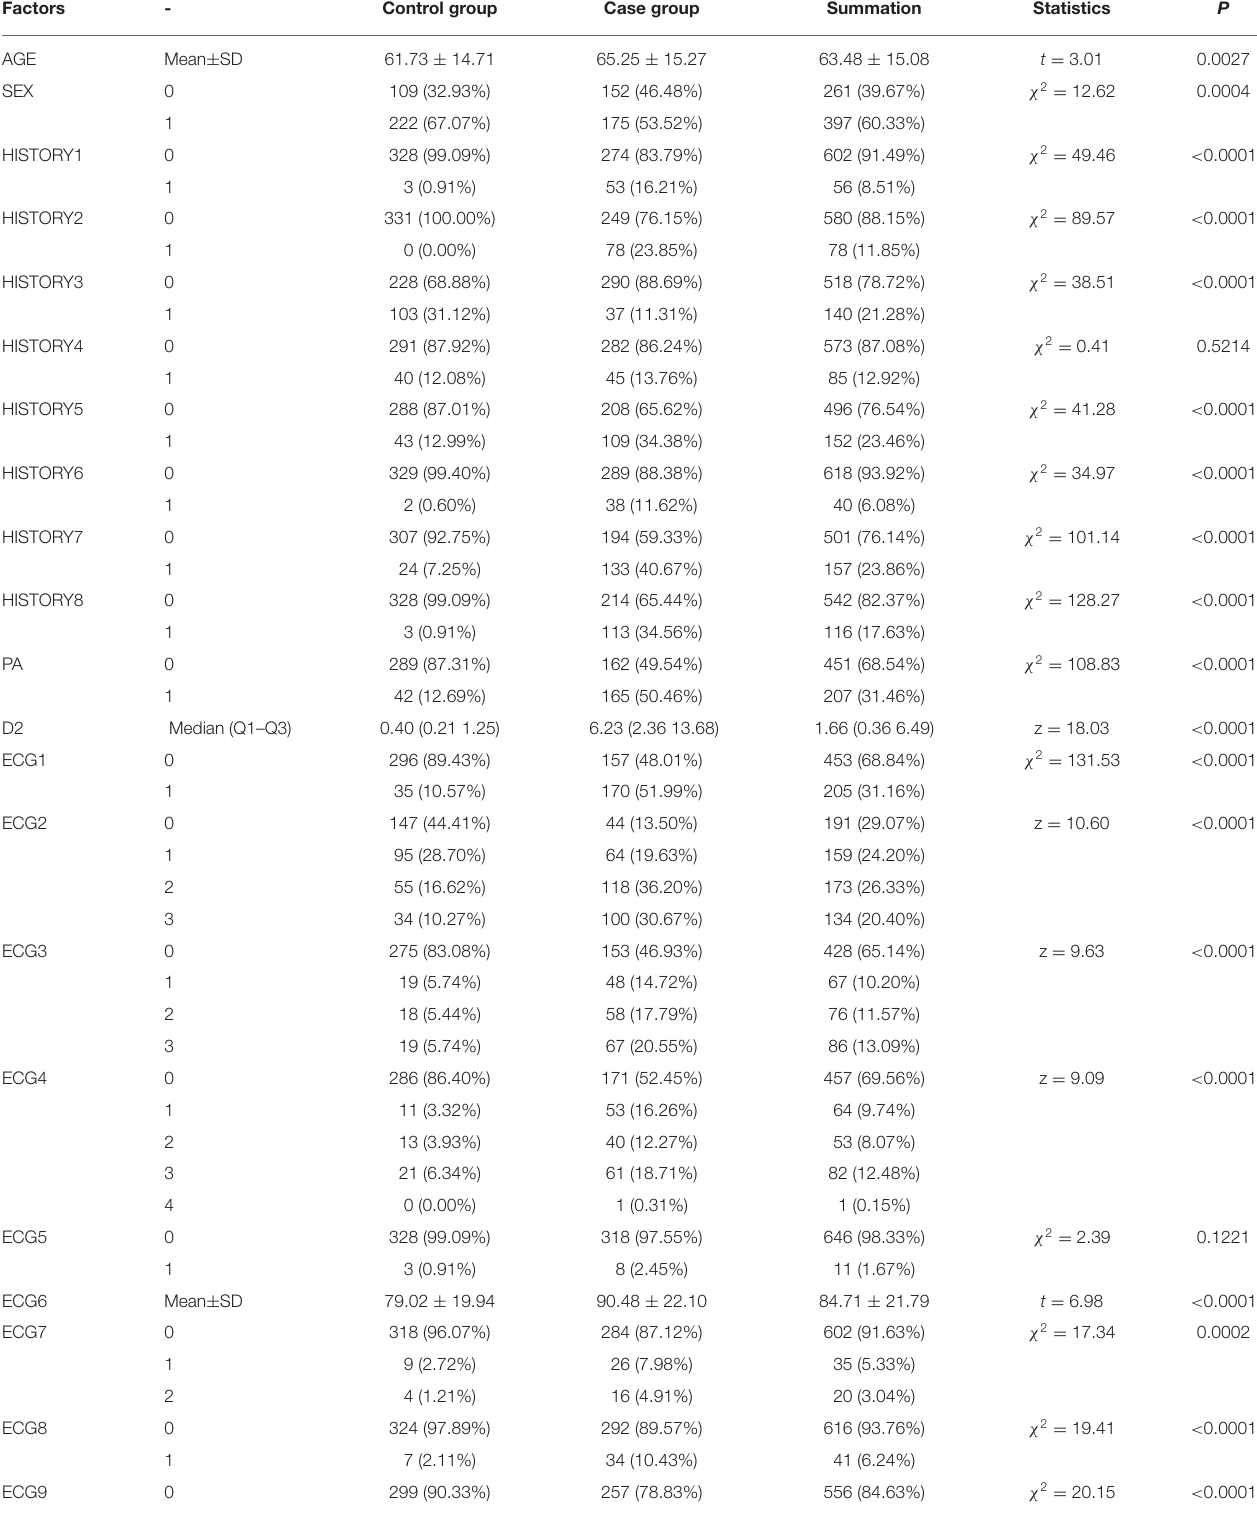
TABLE 2 | The comparison of factors between control group and case group.